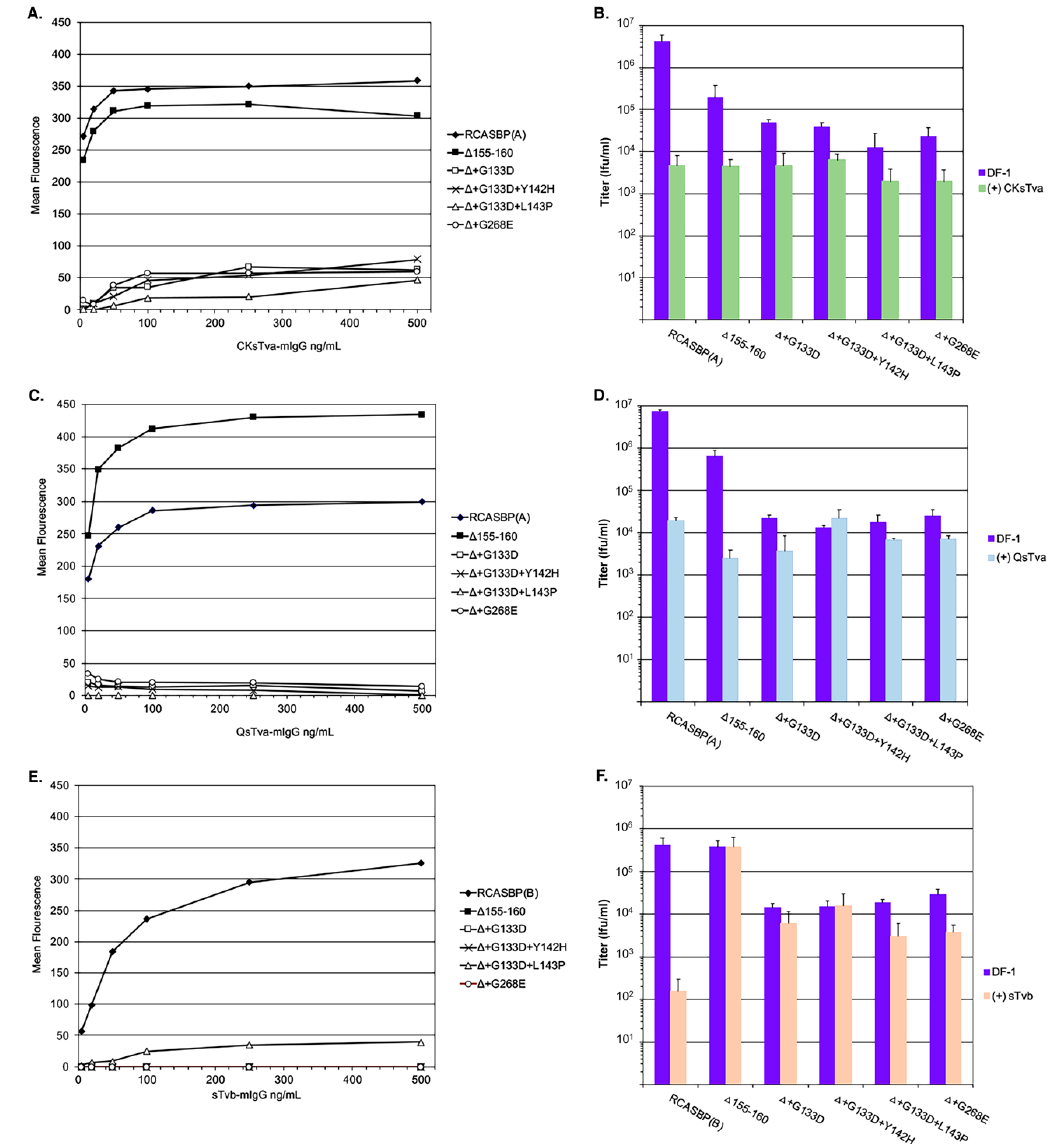
Figure 5. Analysis of the binding affinities and antiviral effects of receptor immunoadhesins on the evolved RCASBP(A) Δ 155–160 virus variants. DF-1 cells infected with either control and variant ASLVs were fixed and incubated with different amounts of either the CKsTva-mIgG ( A ), QsTva-mIgG ( C ), or sTvb-mIgG ( E ) soluble ASLV receptor immunoadhesins and the envelope glycoprotein:soluble receptor complexes bound to sheep anti-mouse Ig antibody linked to fluorescein. The levels of fluorescein bound to the infected cells were quantitated by fluorescence-activated cell sorting (FACS) and the mean level of fluorescence was plotted as a function of soluble ASLV receptor concentration. Representative experiments are shown. Infectious titers were determined using 10-fold serial dilutions of control and variant ASLVs supernatants directly on DF-1 cells, or after each dilution was preabsorbed with a set amount of CKsTva-mIgG ( B ), QsTva-mIgG ( D ), or sTvb-mIgG ( F ) to allow the soluble receptor time to bind and inhibit infection of DF-1 cells. The infectious titer was determined by the AP assay.